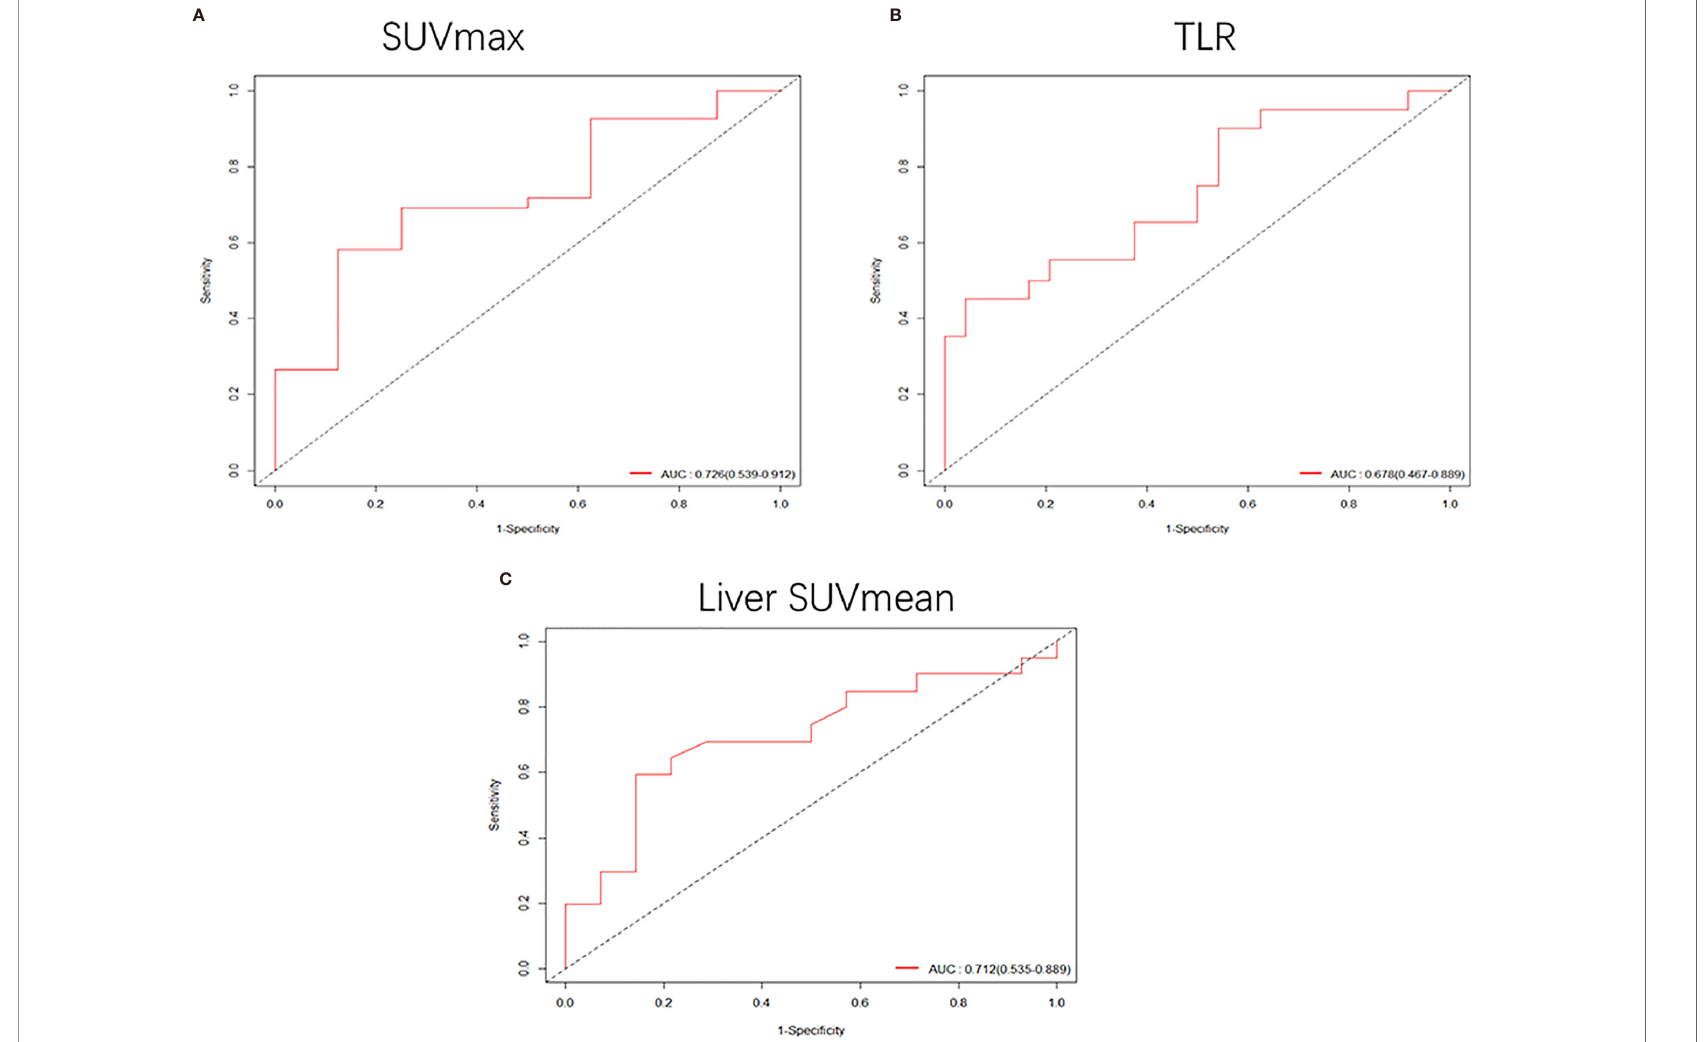
FIGURE 5 | (A, B) When the tumor size was 3-4 cm, the receiver operating characteristic (ROC) curves based on SUVmax and TLR were 0.726 (95%CI, 0.539-0.912) and 0.678 (95%CI, 0.467-0.889), respectively. (C) ROC curve of liver SUVmean when the tumor size was 4-5 cm, AUC: 0.712 (95%CI,